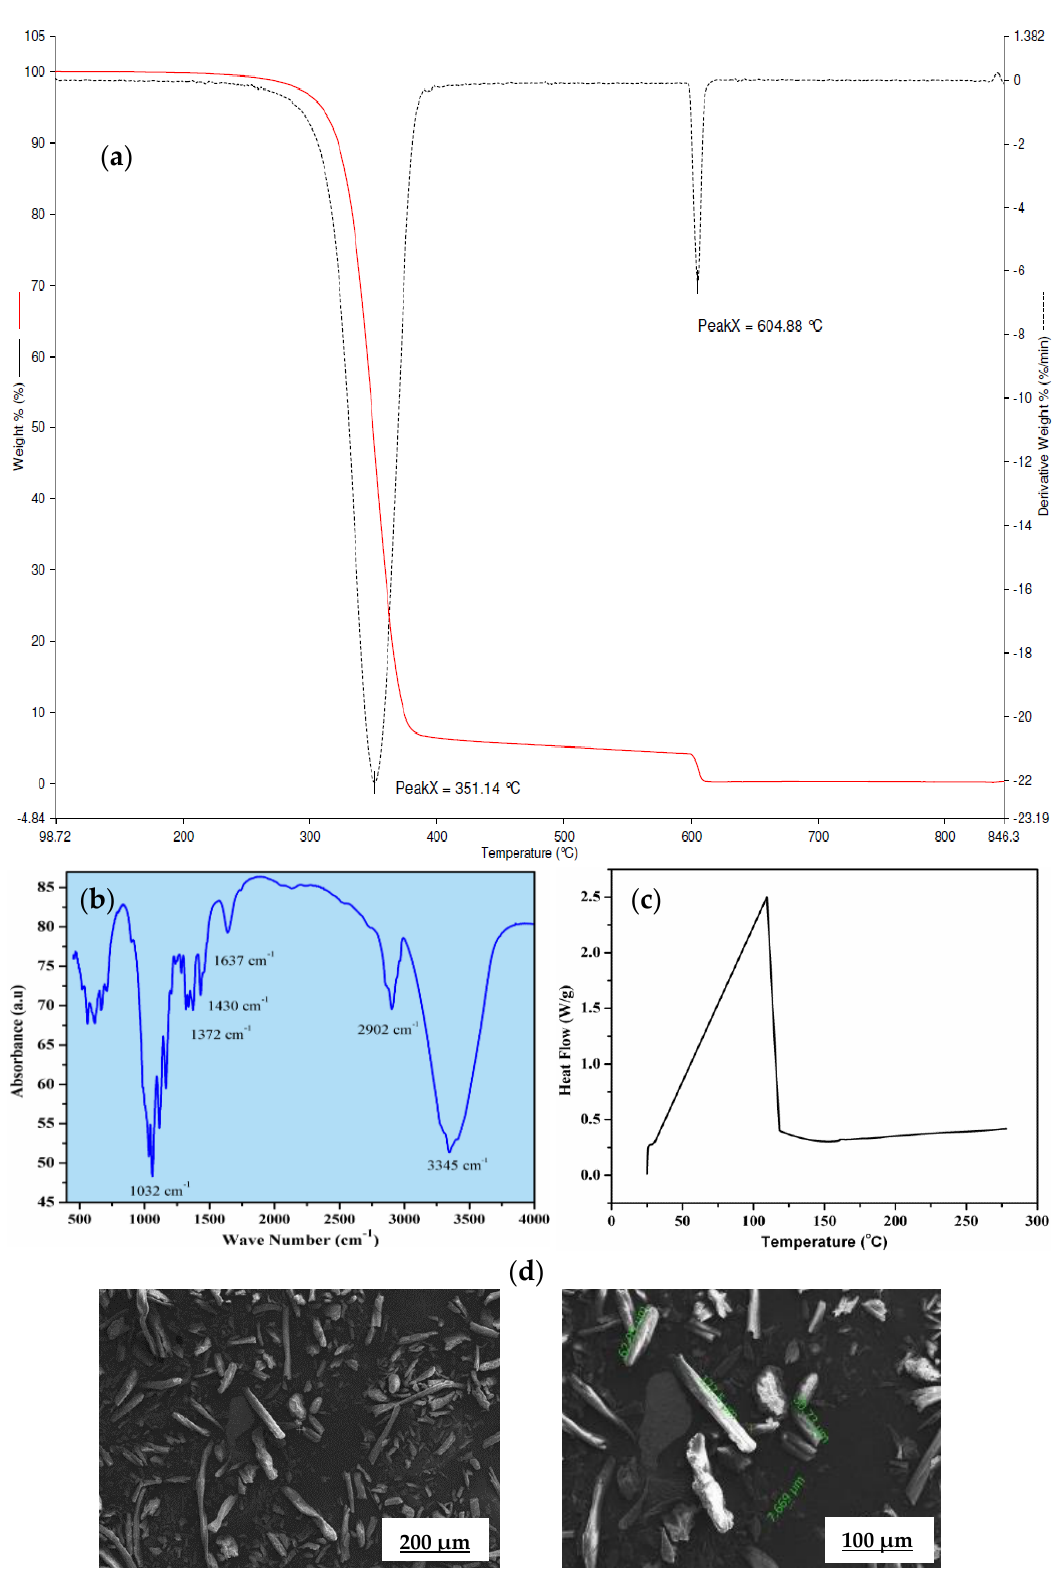
Figure 2. ( a ) Thermo-gravimetric (TG) and differential thermo-gravimetric (DTG) profile of α -cellulose, ( b ) Fourier transform infrared (FTIR) spectrum of α -cellulose, ( c ) heat flow curve of α -cellulose, ( d ) scanning electron microscopic (SEM) images of α -cellulose at 500 × and 1000 ×